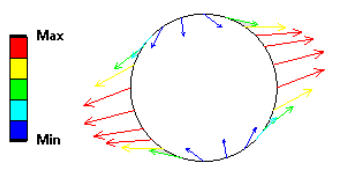
Fig. 5. Stress vectors on the surface of an elementary